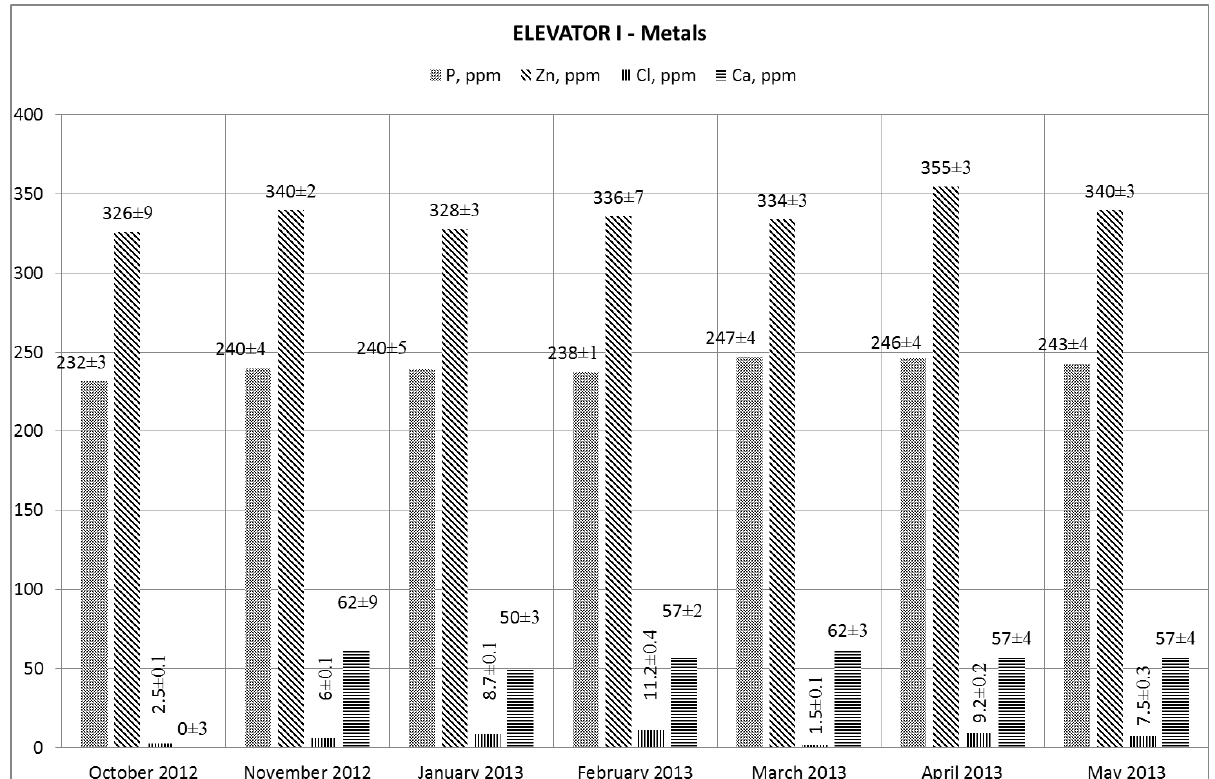
Figure 8. Metals in Elevator